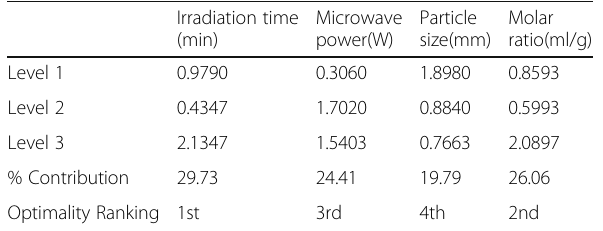
Table 3 Main effect of response means